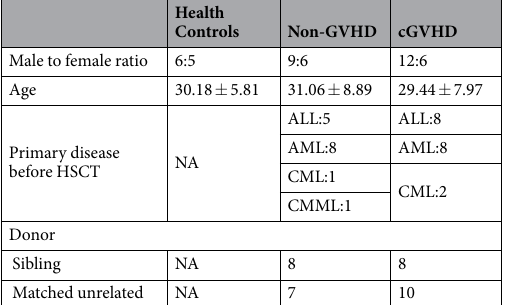
Table 1. Clinical characteristics of the study population. Abbreviations: ALL = acute lymphoblastic leukemia; AML = acute myeloid leukemia; CML = chronic myelogenous leukemia; CMML = Chronic myelomonocytic leukaemia; NA = not